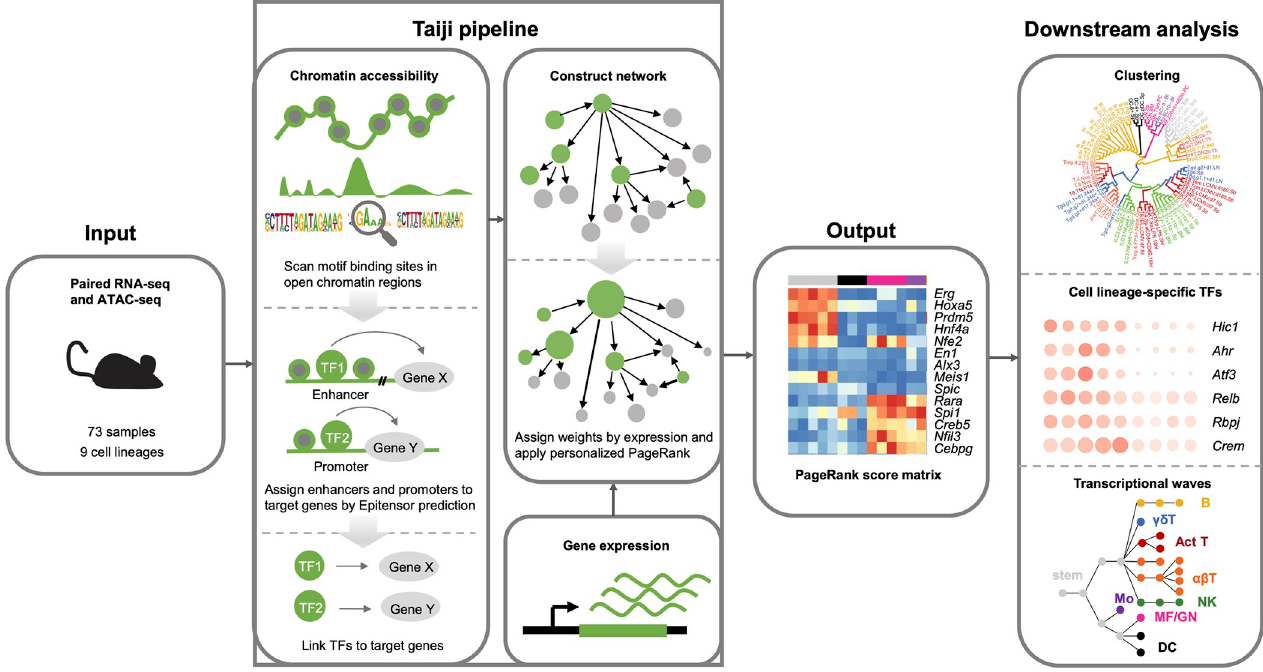
Fig 1. The workflow of study and Taiji pipeline. Matched RNA-seq and ATAC-seq data were used as input for the Taiji framework to construct a regulatory network and generate PageRank scores matrix as output (column colors code for different cell lineages, see Fig 2 for the color annotation). Downstream analyses included clustering samples to distinct cell lineages, identification of cell lineage-specific TFs, and construction of temporal transcriptional waves.